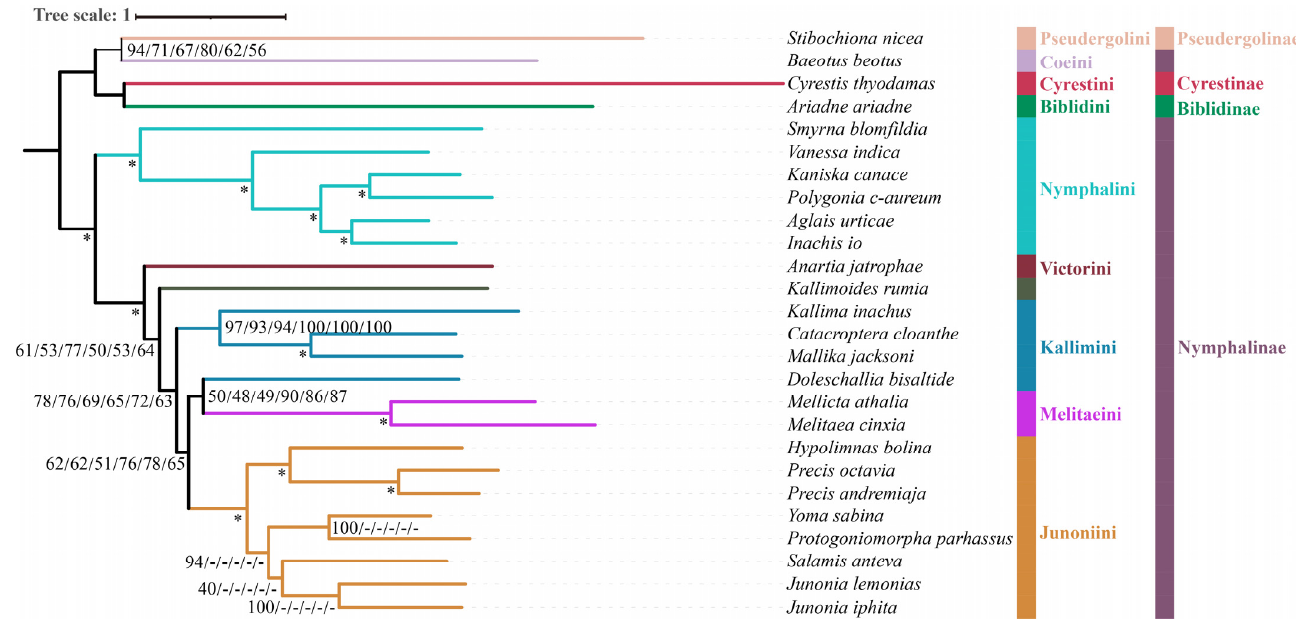
Figure 3. Phylogenetic analysis using the ML method based on the datasets of PCG123, PCG123R, PCG123RT, PCG123N, PCG123RN, and PCG123RTN. Bootstrap support (BS) values at nodes (from left to right) represent support for PCG123, PCG123R, PCG123RT, PCG123N, PCG123RN, and PCG123RTN datasets, respectively. The “-” indicates the clades are di ff erent. Maximum support values produced are indicated by star symbols.